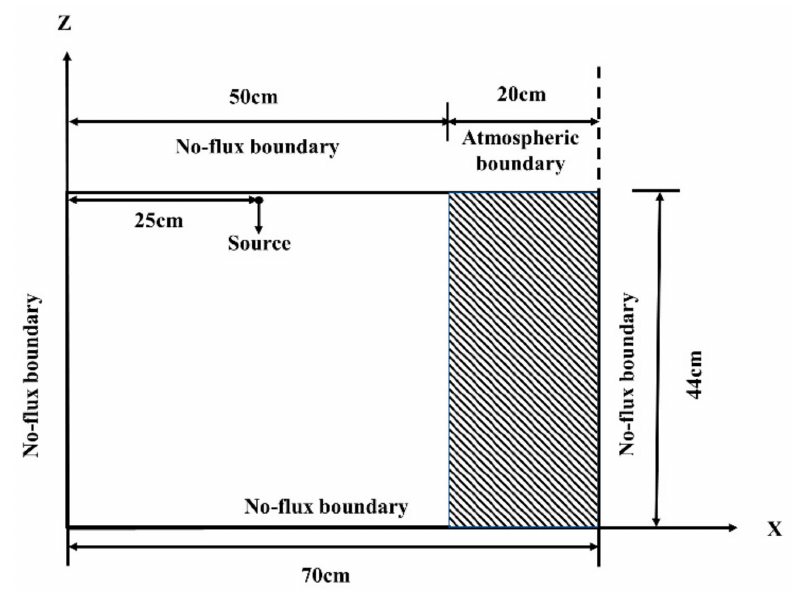
Figure 3. The schematic diagram of the model and its water